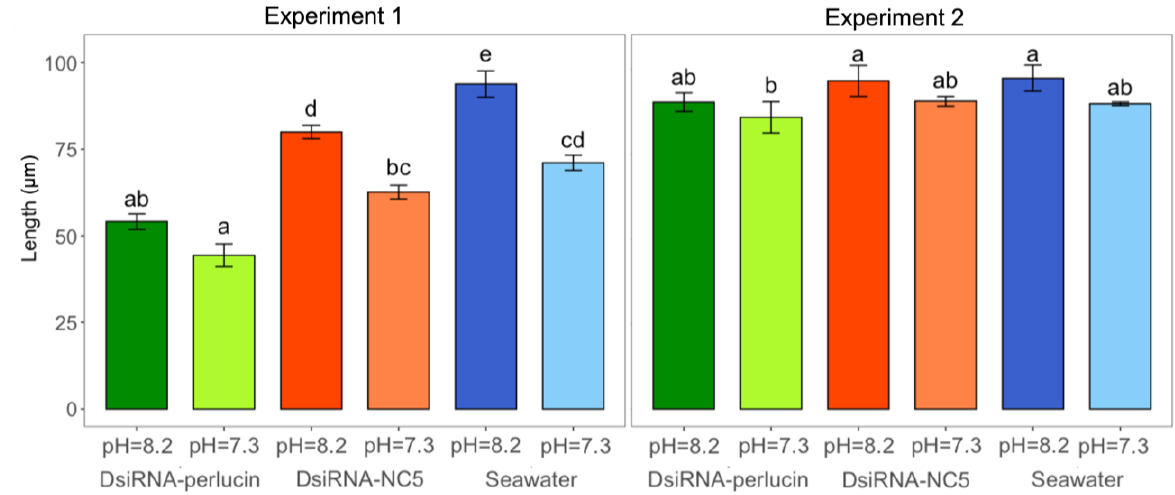
Figure 6. Length (mean ± sd) among silenced (DsiRNA-perlucin (green)) and control (DsiRNA-NC5 (orange) and seawater (blue)) oysters cultured under different p CO 2 treatments (lighter shades for pH = 7.3 and darker for pH = 8.2). Different letters (a, b, c, d, and e in Experiment 1 and a and b in Experiment 2) denote significant differences between treatments within each experiment (nested ANOVA; Tukey post hoc test, n = 3; p -value < 0.04). Silenced larvae were systematically smaller than their respective controls (DsiRNA-NC5 and seawater) and differences were significant for Experiment 1. Larvae were sampled on day 3 for Experiment 1 and day 5 for Experiment 2.